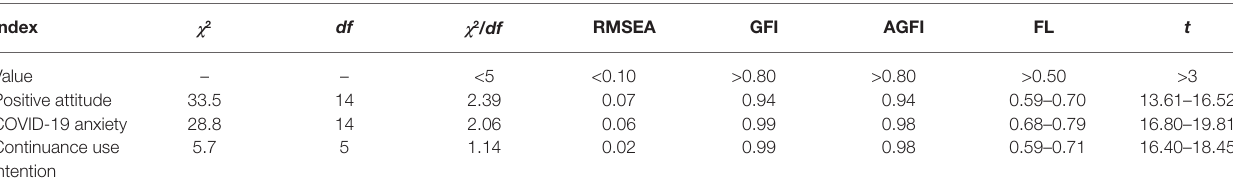
TABLE 1 | First-order confirmatory factor analysis